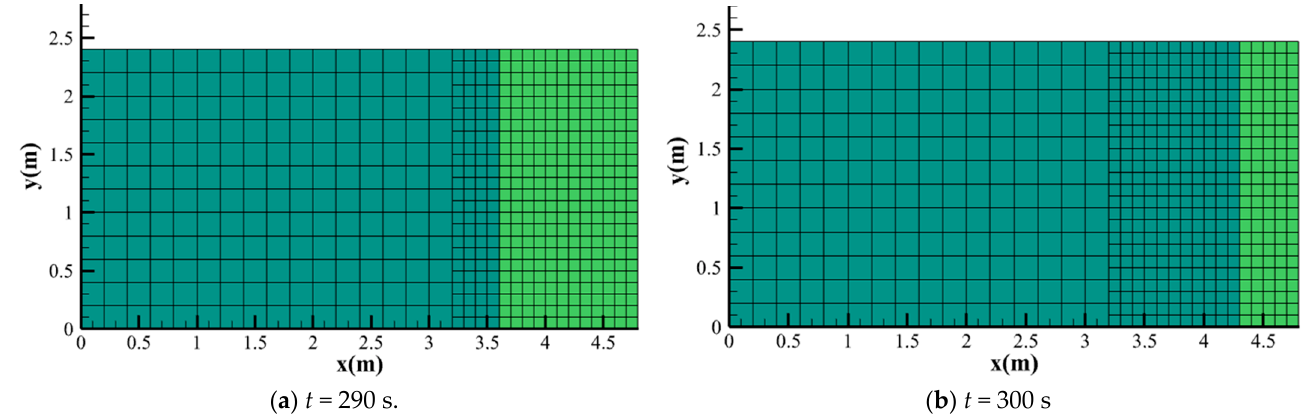
Figure 8. The positions of the internal moving boundary between the SWEs and DWEs in the fine grids at different times.